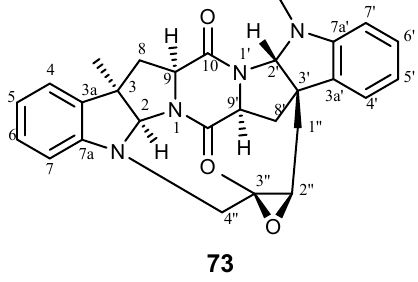
Figure 14. Structure of nocardioazine A ( 73 ).